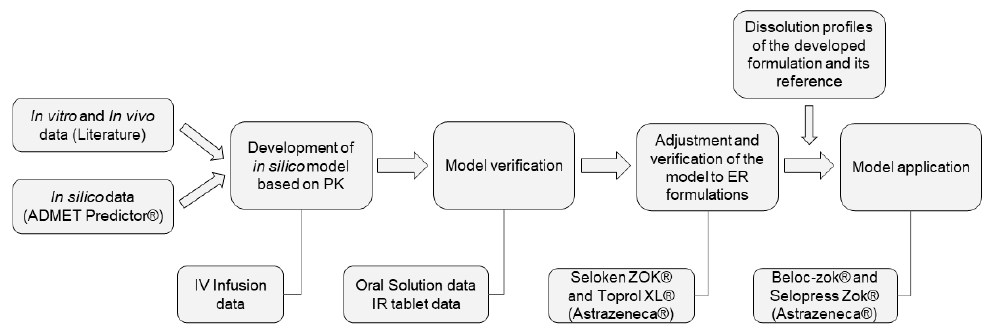
Figure 1. Major steps of the PBBM approach.